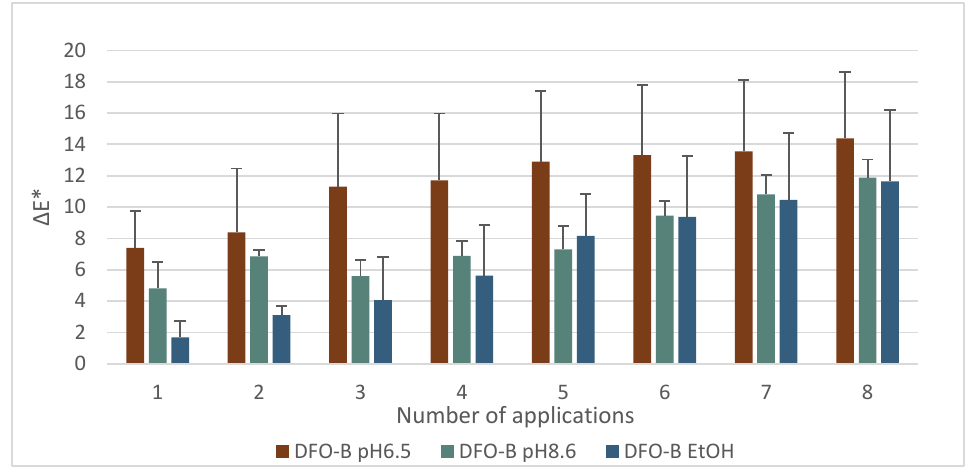
Figure 8. ΔE* of mock -ups after the 8th application of DFO-B hydrogels at pH 6.5 and pH 8.6 and Figure 8. ∆ E* of mock-ups after the 8th application of DFO-B hydrogels at pH 6.5 and pH 8.6 and the the ethanol gel (EtOH). All ΔE* values are average s of four replicates. ethanol gel (EtOH). All ∆ E* values are averages of four replicates.